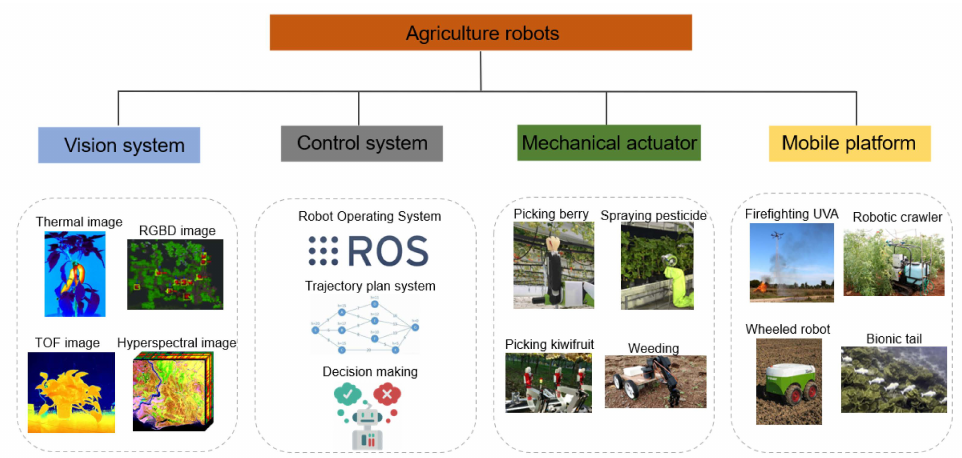
Figure 5. Implications of robotic components